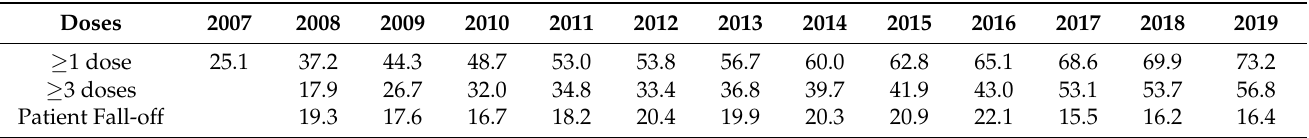
Figure 1. Incidence rate of malignant cervical cancer-SEER Research Data, 18 Registries (excl AK),